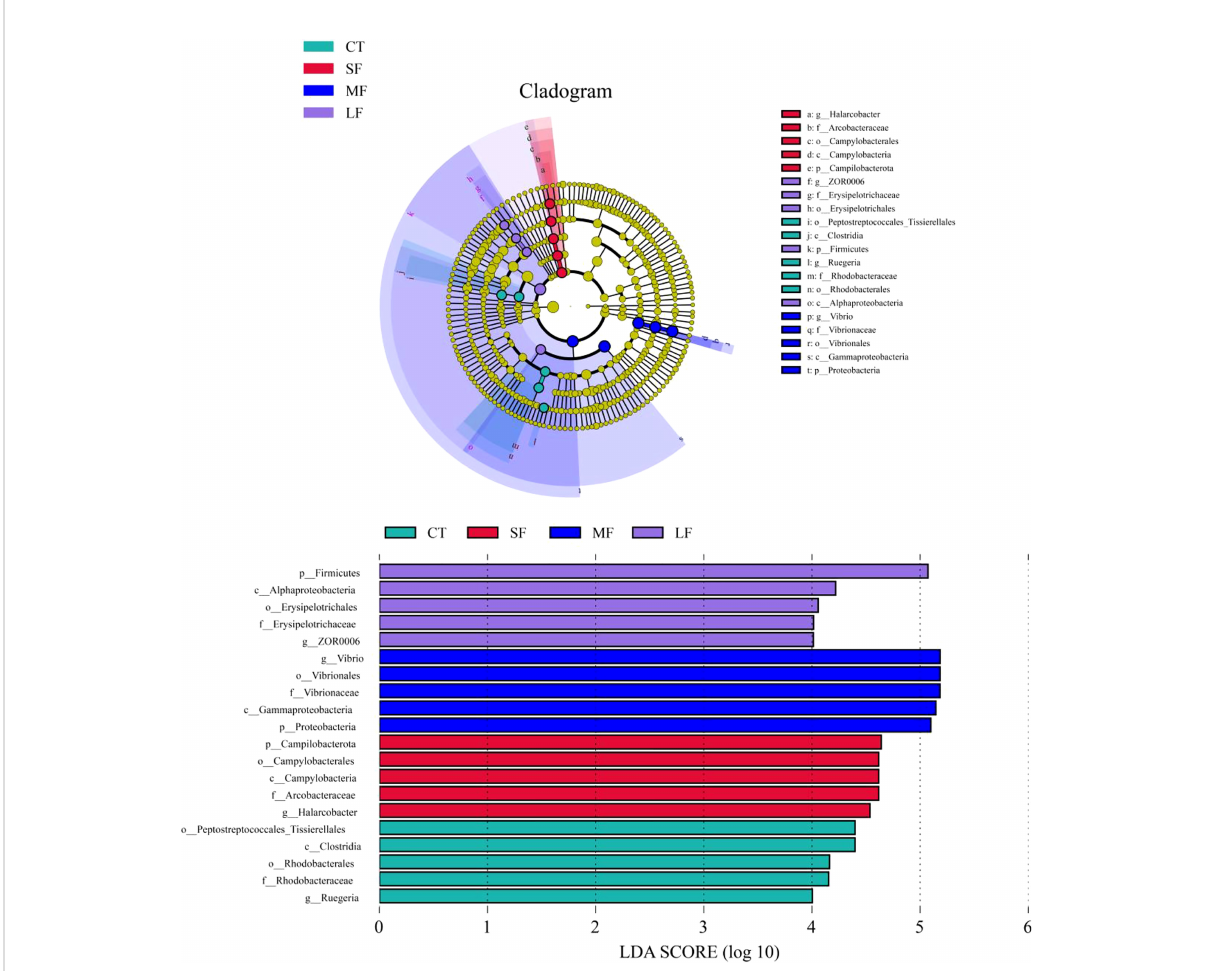
FIGURE 9 Linear discriminant analysis (LDA) effect sizes (LEfSe) were used to identify potentially unique biomarkers for each group. The circles represent the phylogenetic level from the phylum to the genus. The diameter of each circle is proportional to the abundance of the taxonomic unit. Differences are indicated by the colour of the most abundant